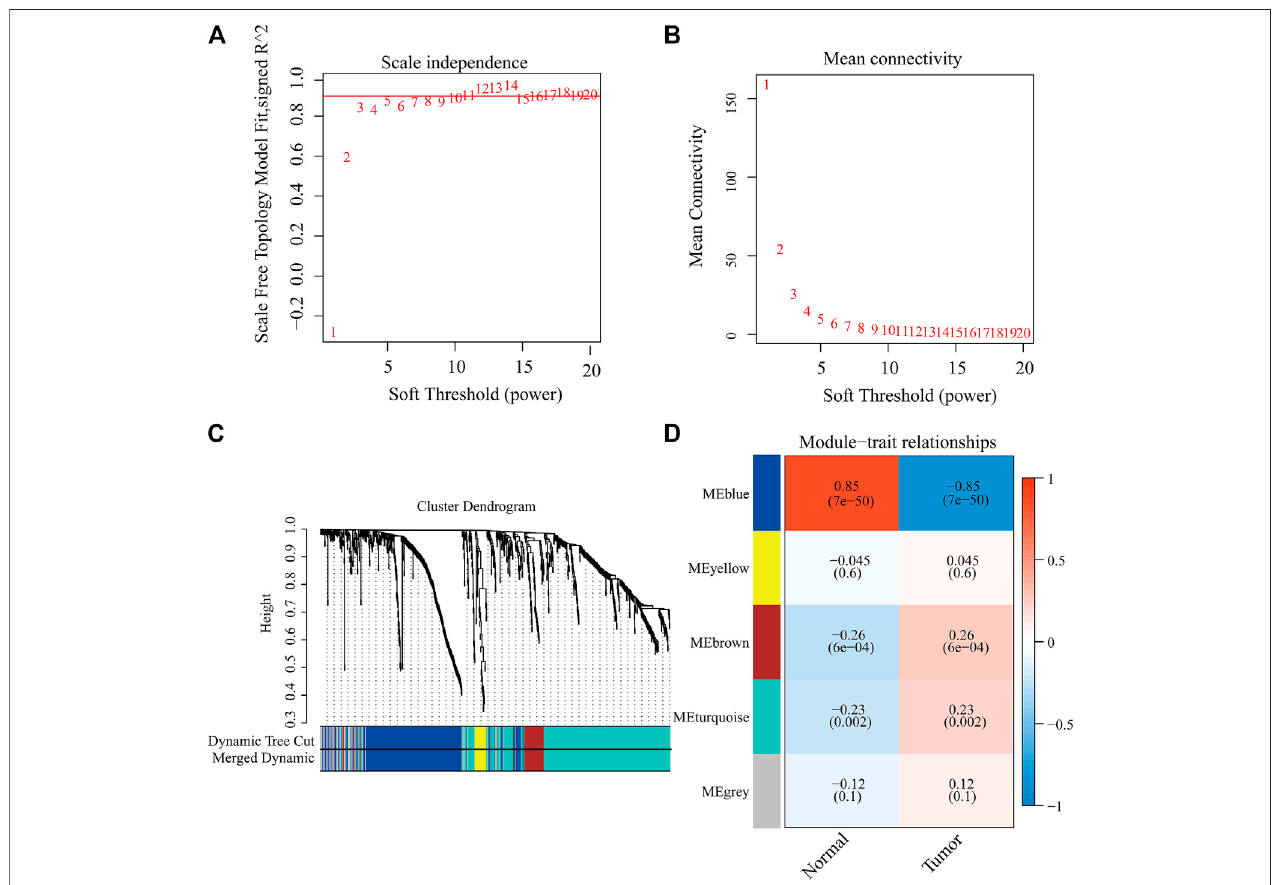
FIGURE3| Identi fi cation ofmodules associatedwiththeclinicaltraitsofGBMintheWGCNA. (A) Analysisofthescale-freeindexforvarious soft-thresholdpowers ( β ). (B) Analysisofthemean connectivityforvarious soft-thresholdpowers. (C) Dendrogram ofall differentially expressed genesclustered based onthe measurement of dissimilarity (1-TOM). (D) Heatmap of the correlation between the module eigengenes and CDCP1 expression level of GBM. The color band shows the results obtained from the automatic single-block analysis.